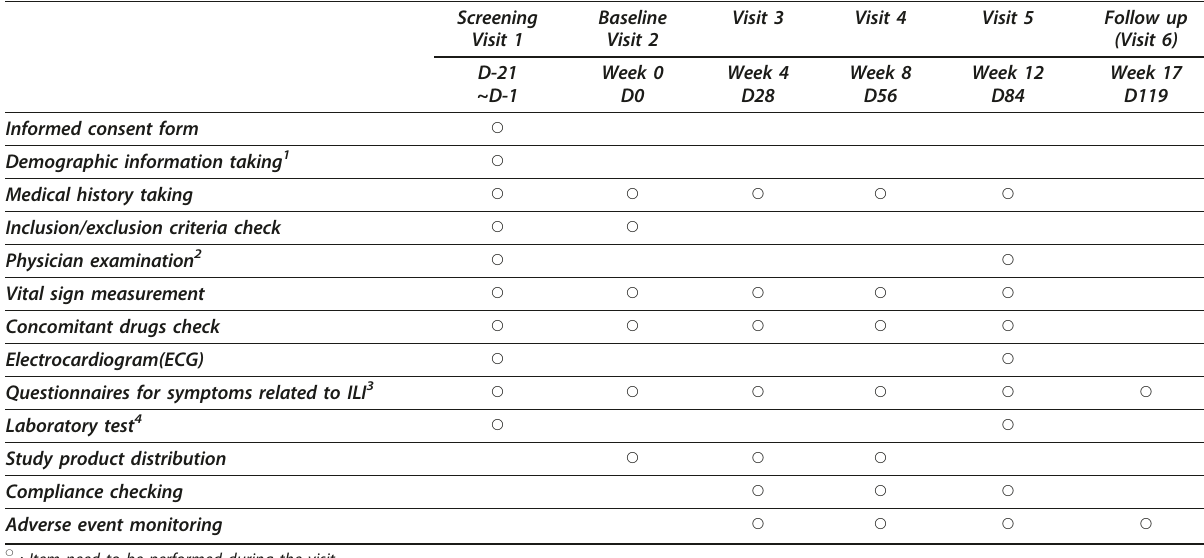
Table 1 A brief study schedule at every visit.